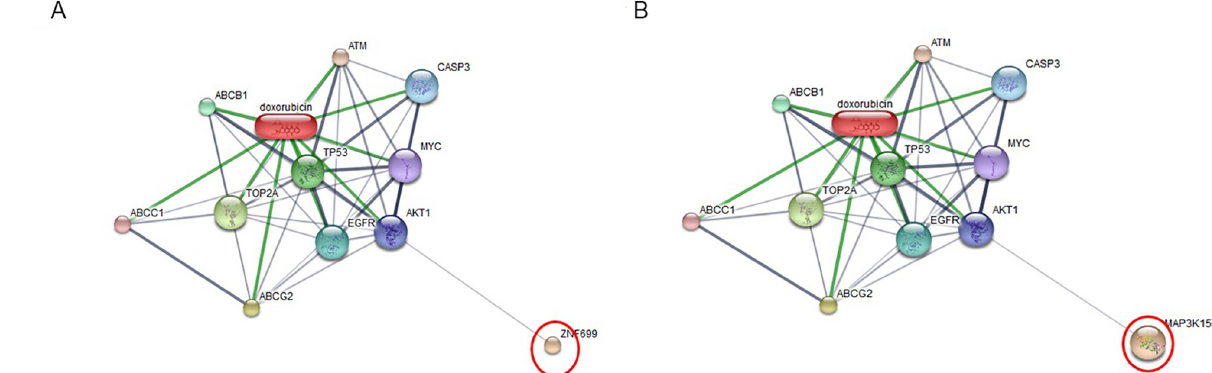
Fig 7. Involvement of zinc finger protein 699 (ZNF699) (A) and mitogen-activated protein kinase kinase kinase 15 (MAP3K15) (B) in networks of protein–chemotherapy drug interactions, doxorubicin. Red circles: ZNF699 and MAP3K15. Abbreviations: ABCB1, ATP-binding cassette, sub- family B, member 1; ABCC1, ATP-binding cassette, sub-family C, member 1; ABCG2, ATP-binding cassette, sub-family G, member 2; AKT1, v-akt murine thymoma viral oncogene homolog 1; ATM, ataxia telangiectasia mutated; CASP3, caspase 3; EGFR, epidermal growth factor receptor; MYC, v- myc myelocytomatosis viral oncogene homolog; TOP2A, topoisomerase II alpha; TP53, tumor protein p53.